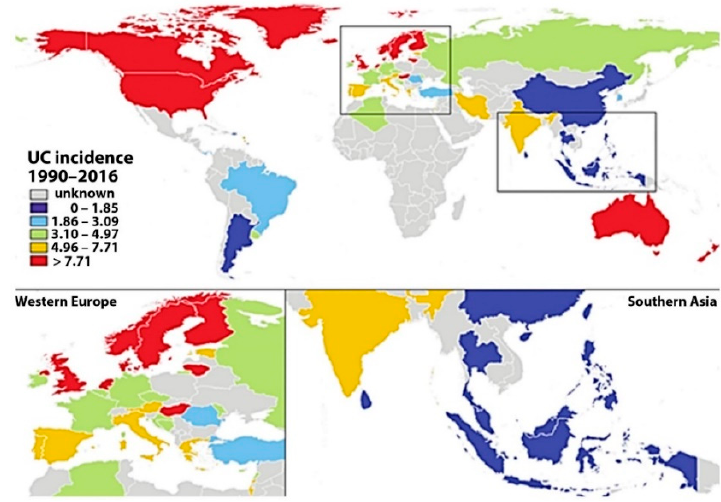
Figure 4. Ulcerative colitis (UC) incidence map between 1990–2016 [44].